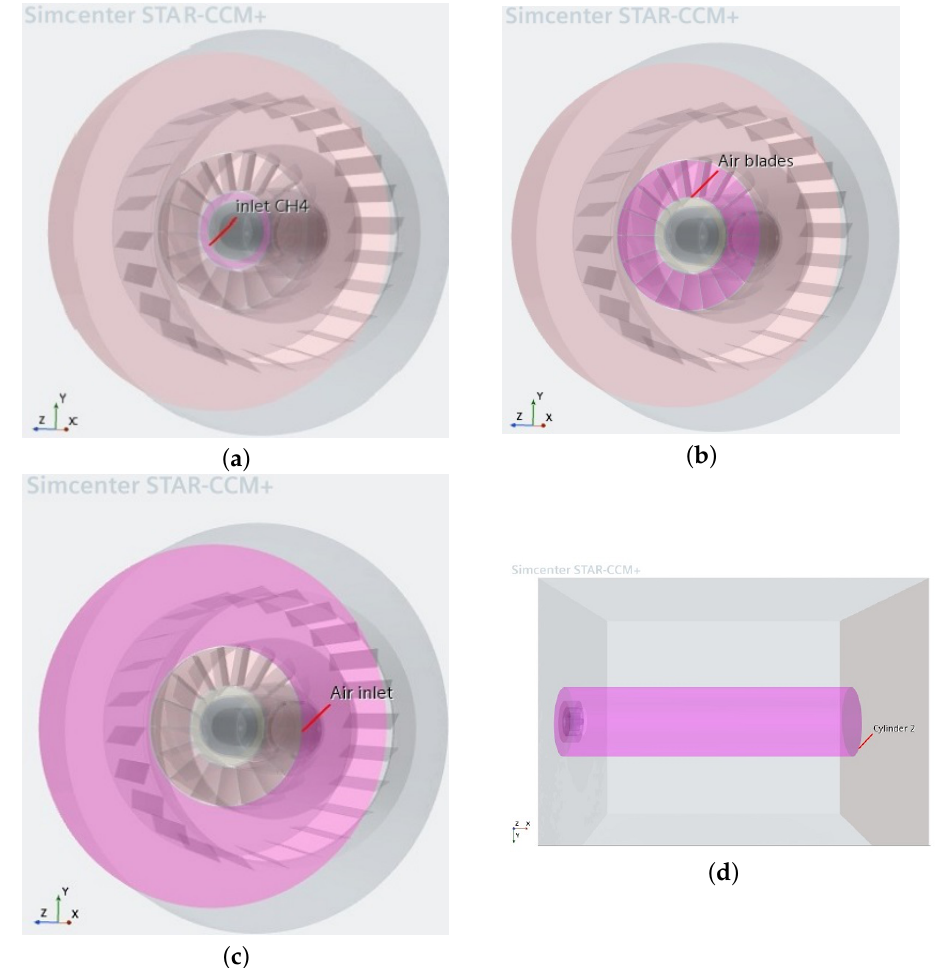
Figure 1. Three dimensional model of the burner in the STAR-CCM+ environment: ( a ) gas inlet;